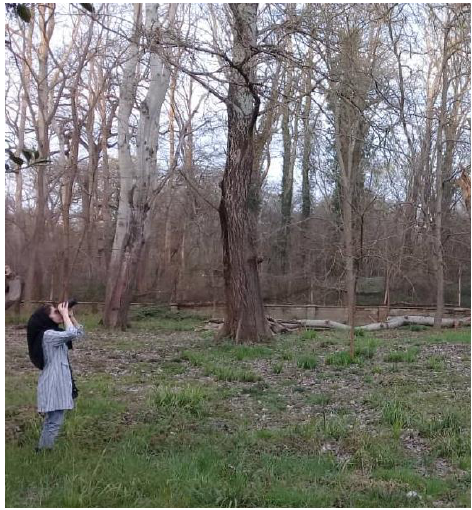
Figure 2 . Observation of trees flowers for their sex determination